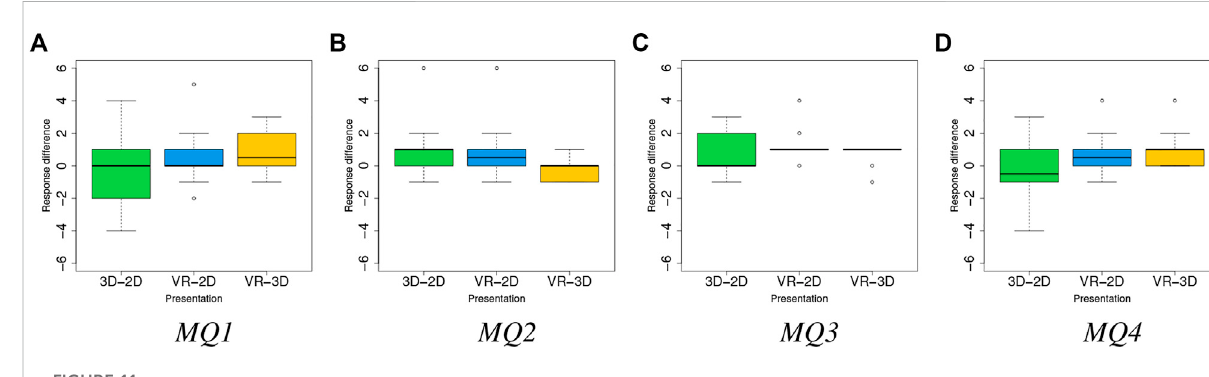
FIGURE 11 Distributions of difference in within-subjects ratings of MQ1 (A) , MQ2 (B) , MQ3 (C) and MQ4 (D)